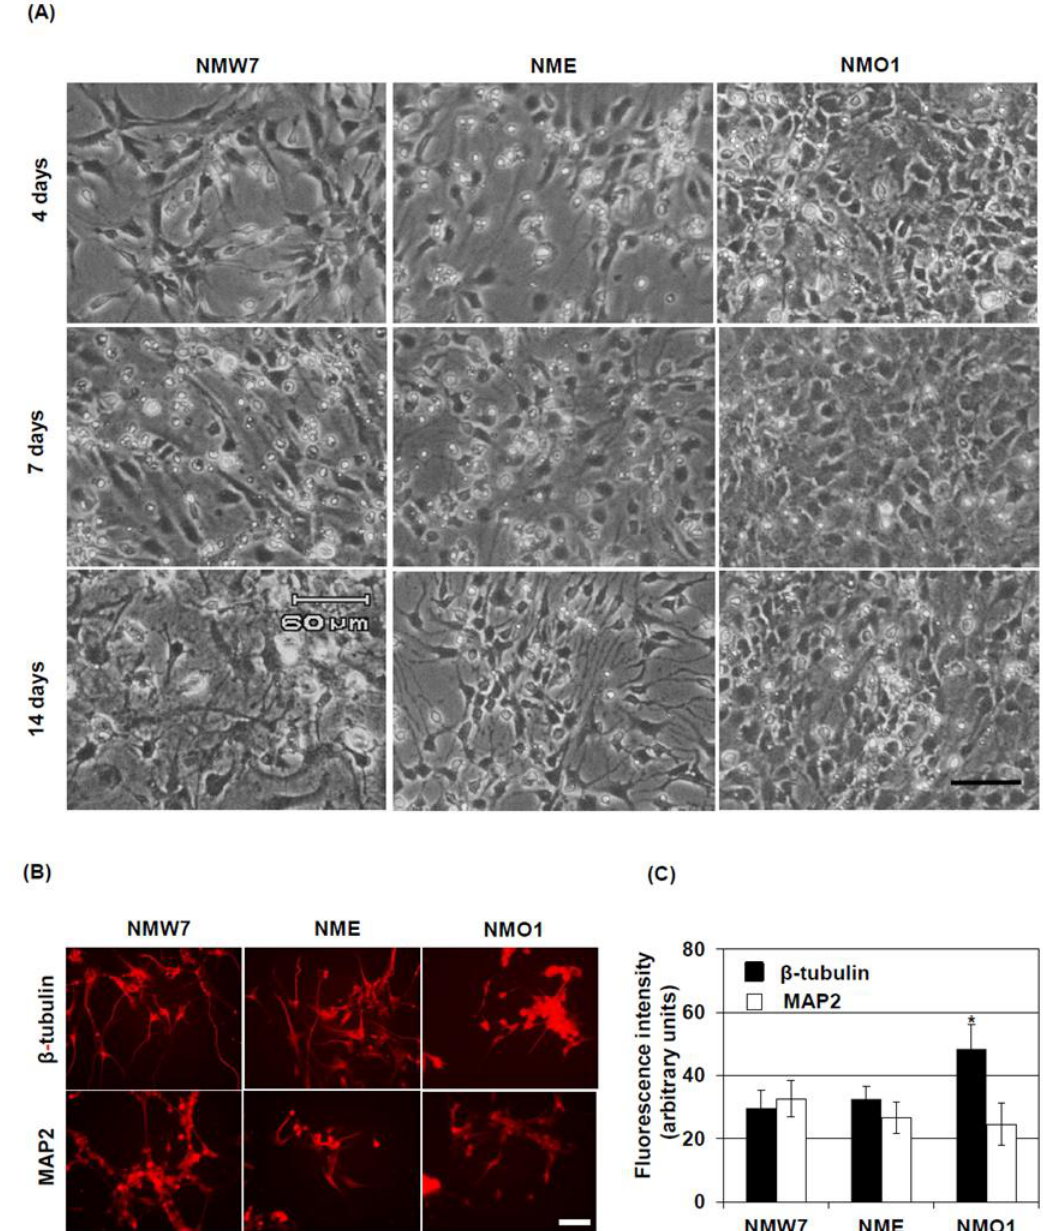
Figure 5. Differentiation of the generated neural stem cell lines: Neuronal differentiation was induced in NMW7, NME, and NMO1 cells using differentiation culture medium and poly-L-lysine coated plates, as described in the Materials and Methods section. Time-dependent morphological changes of the cell lines during differentiation in culture were evaluated using a cell culture microscope. ( A ) Representative photomicrographs of NMW7, NME, and NMO1 cells under neuronal differentiation conditions at 4, 7, and 14 days in culture are shown here. Scale bar = 60 µm. ( B , C ) Protein expressions of β -tubulin and microtubule-associated protein 2 (MAP2) after differentiation were evaluated using immunofluorescence staining. ( B ) Representative photomicrographs of β -tubulin and MAP2 immunofluorescence staining of NMW7, NME, and NMO1 cells after neuronal differentiation are shown here. Scale bar = 50 µm. ( C ) Fluorescence intensities of β -tubulin and MAP2 were quantified as described in the Materials and Methods section, and average fluorescence intensities are shown. Numerical data are presented as averages ± SD of 3 independent experiments. Statistical significance is denoted as follows: * p < 0.05 vs. NMW7.